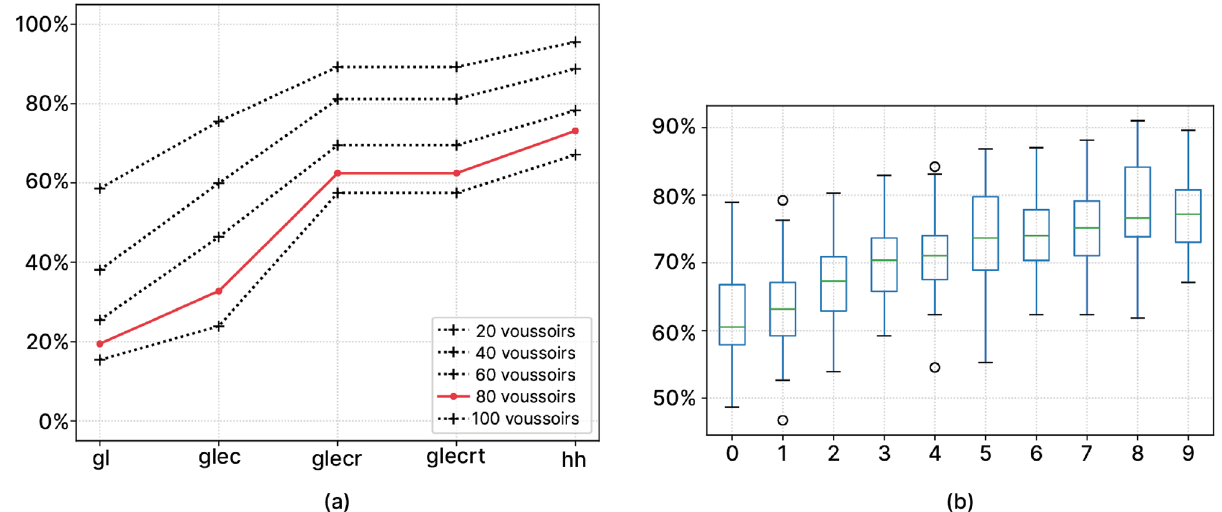
Figure 8. ( a ) Percentage of the milestone models confidence per number of voussoirs; ( b ) percentage of the hybrid hypothesis confidence for 79 voussoirs per number of physical anastylosis provided